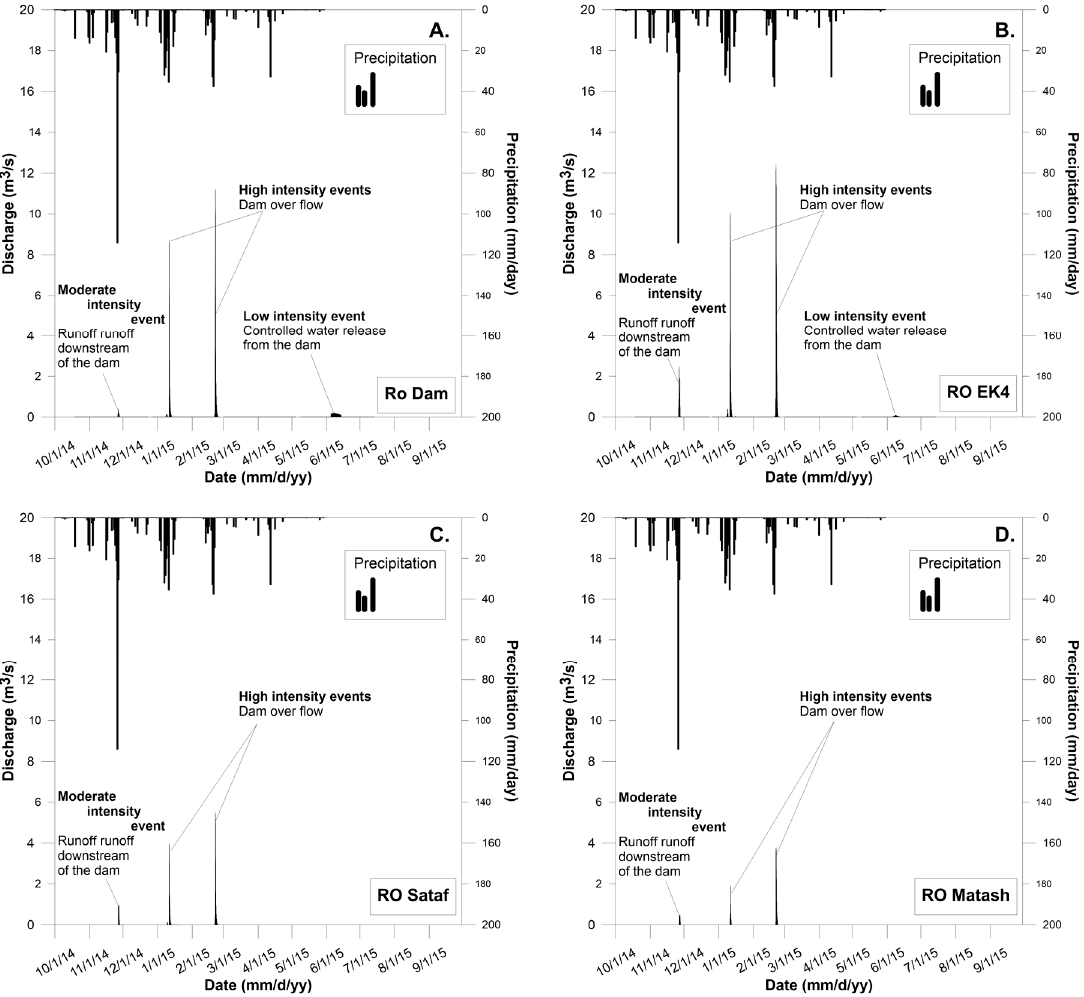
Figure 2. Observed runoff discharge at the ( A ) RO Dam; ( B ) RO EK4; ( C ) RO Sataf; and ( D ) RO Matash gauging stations, and measured daily rainfall data from Tzuba Meteorological station.